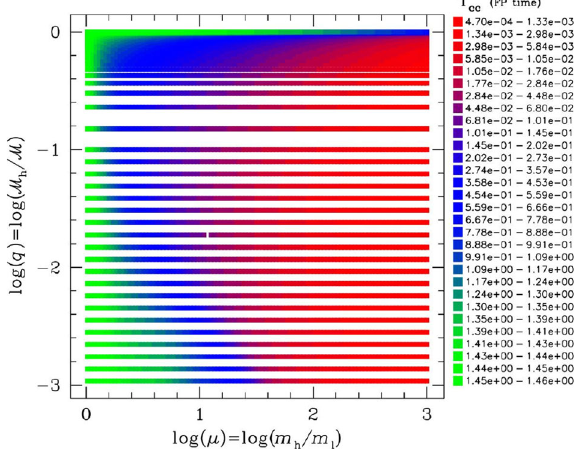
Fig. 25 Parameter space for the set of 10 4 simulations. Here, t end stands for the core collapse time and is expressed in FP units (see text); time at which the simulation ended. q and μ are plotted logarithmically